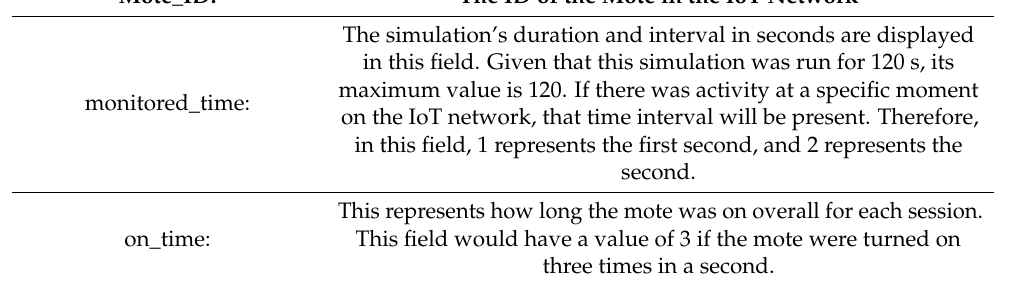
Table 2. Attributes of Power Tracker file.